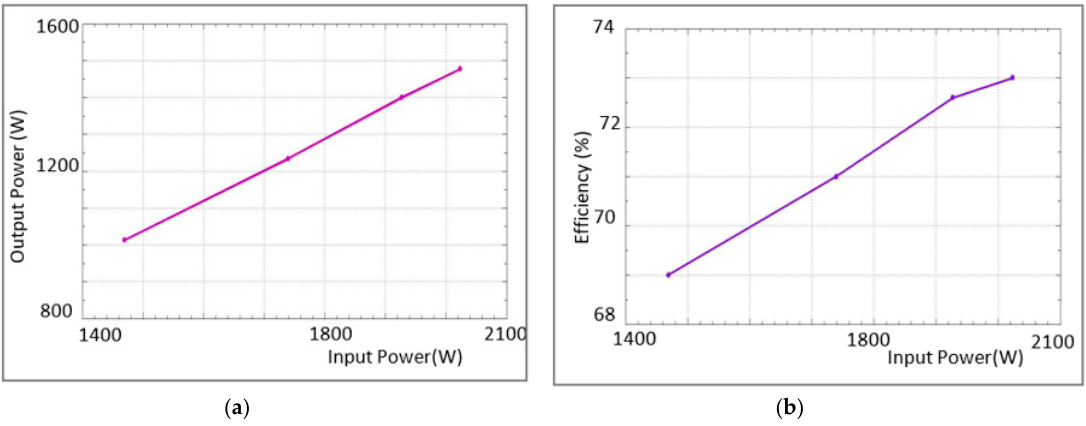
Figure 12. SPS control DAB-IBDC converter power conversion efficiency for the different input solar power. ( a ) Shows the the achieved output power of the SPS control DAB-IBDC converter and ( b ) shows the power conversion efficiency of the SPS control DAB-IBDC converter.